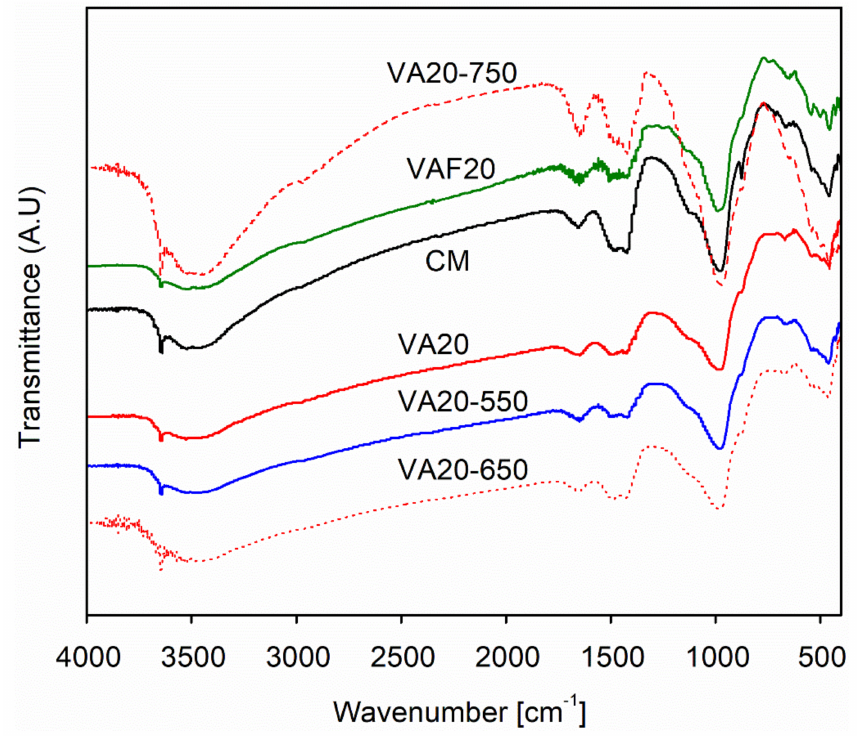
Figure 11. FTIR intensities for control mortar (CM) paste and pastes containing different volcanic ashes at 91